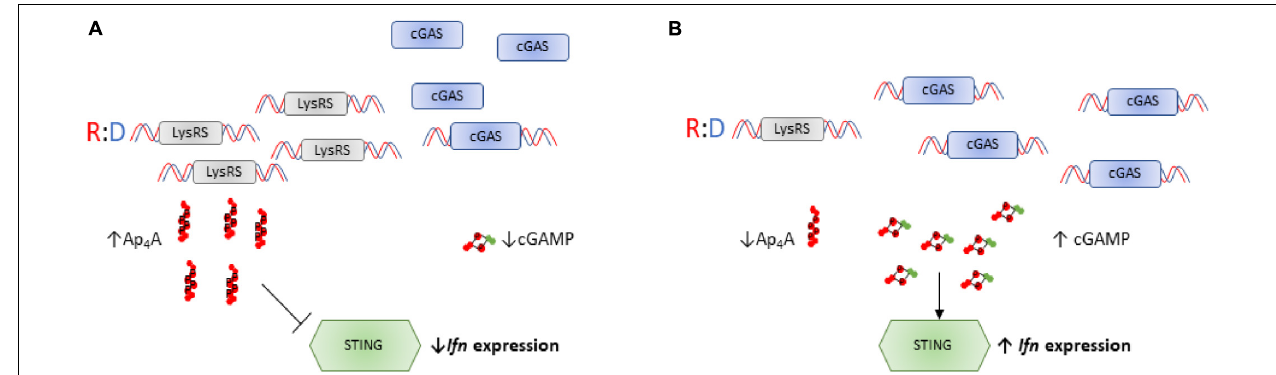
FIGURE 4 | Ap 4 A regulates activity of the cGAS-STING pathway. (A) LysRS suppresses activation of cGAS through two distinct mechanisms: (i) LysRS competes with cGAS for binding DNA hybrids, reducing cGAS:hybrid interactions and therefore reducing synthesis of cGAMP (ii) LysRS synthesizes Ap 4 A which binds to STING in the cGAMP binding pocket, delaying interactions between cGAMP and STING (Guerra et al., 2020). This therefore inhibits STING activation and reduces interferon expression. (B) When LysRS levels are low, it cannot successfully compete with cGAS for R:D hybrid binding. This results in efficient cGAS/R:D hybrid interactions and increased cGAMP production (Guerra et al., 2020). High intracellular cGAMP and low intracellular Ap 4 A concentrations results in efficient activation of STING and increased interferon expression.